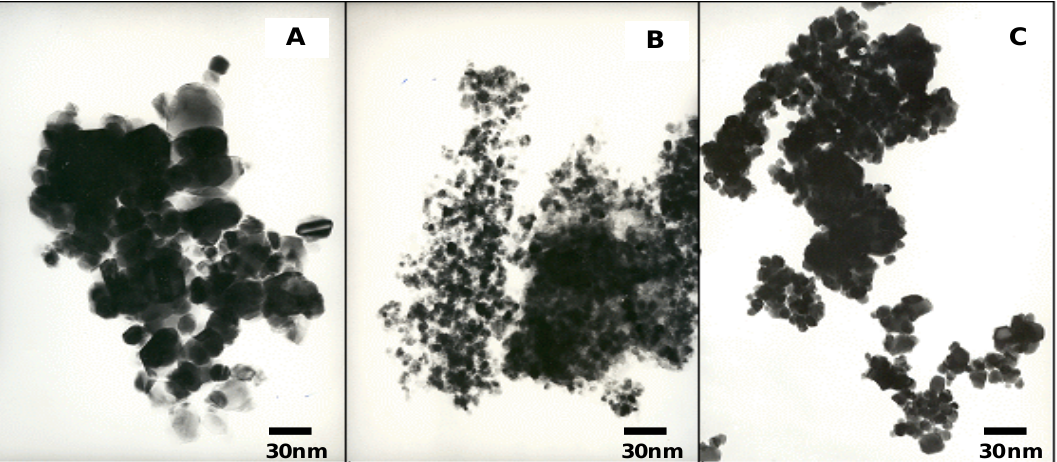
Figure 4. TEM micrographs of SnO calcined at 800 ℃ for 2